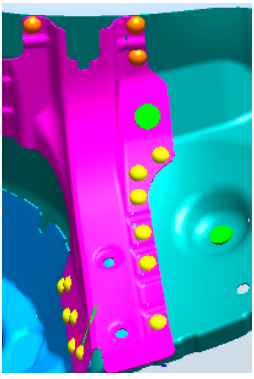
Figure 2. Part of the body in white weld piece.